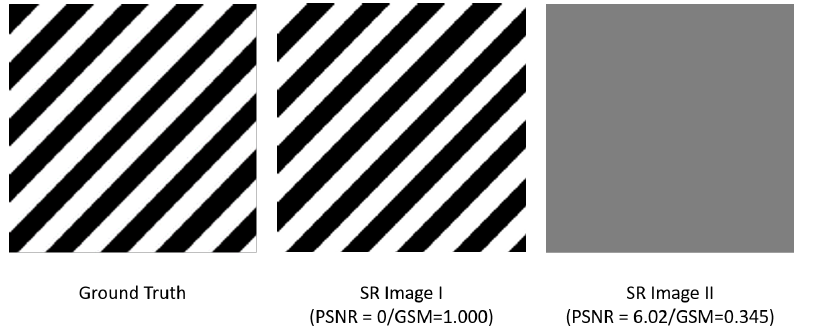
Figure 7. The flaws in PSNR. The second and third patches are the two SR results, while the first one is the ground truth. Notably, the second patch retain the basic shape, but due to the information loss, it introduces geometry error and swaps the white and black area when predicting, thus obtaining a lower PSNR than the third. The GSM metric, on the contrast, evaluates the results